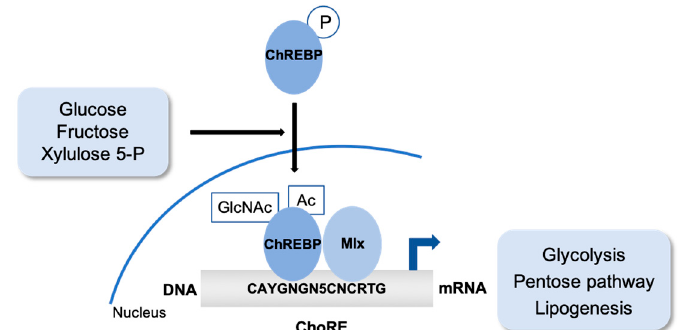
Figure 2. ChREBP is a basic helix–loop–helix leucine zipper transcription factor. In response to glucose and fructose, this protein forms a heterodimer with its partner Mlx and binds and activates the transcription of target genes that contain carbohydrate response element (ChoRE) motifs. This regulation plays a critical role in sugar-induced lipogenesis and global glucose homeostasis. The mechanisms of ChREBP activation involve several glucose metabolites, pathways and post-translational modifications including phosphorylation, acetylation and O–GlcNAcylation.